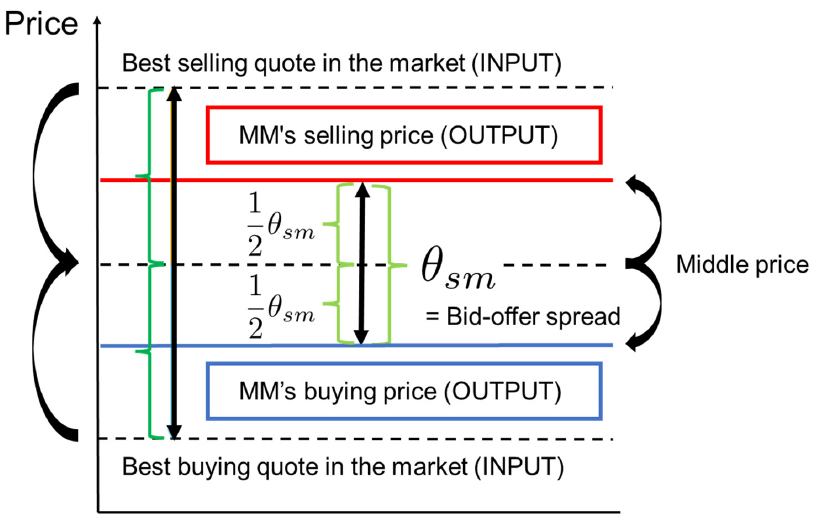
Figure 9. Price determination strategy of the simple market maker when sell and buy orders are both quoted on the order